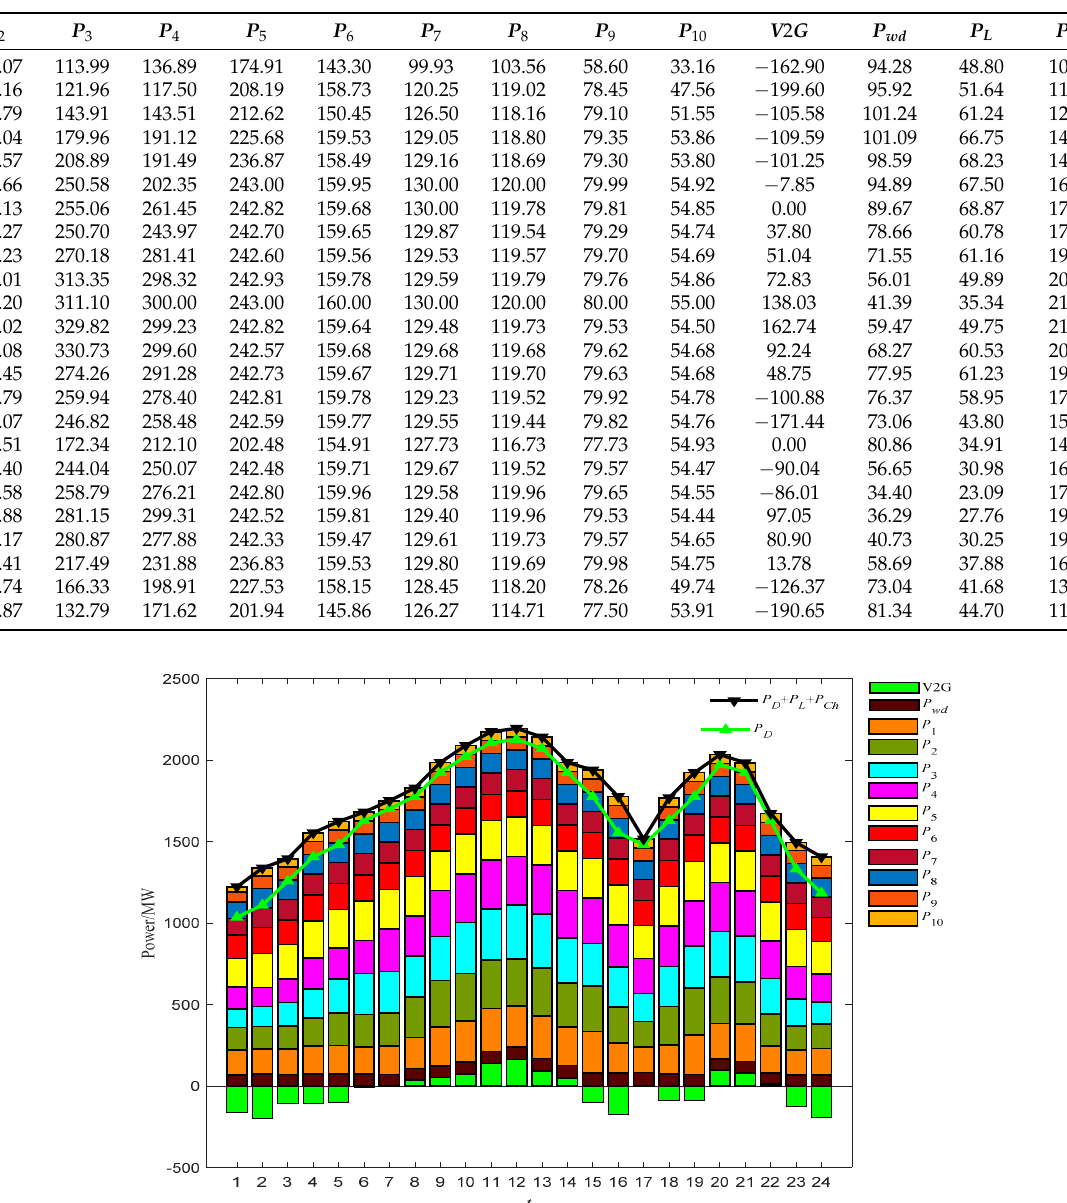
Table 7. The best compromise solution obtained by SAMLHS.